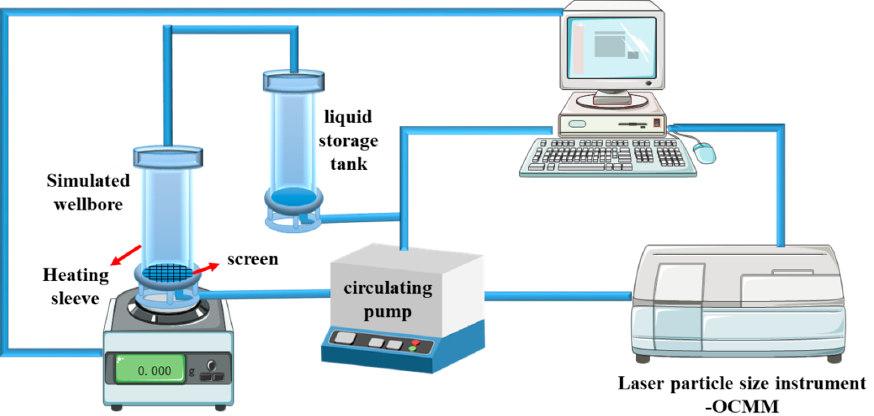
Figure 3. Nano ‐ cleaning fluid evaluation device. Figure 3. Nano-cleaning fluid evaluation device.